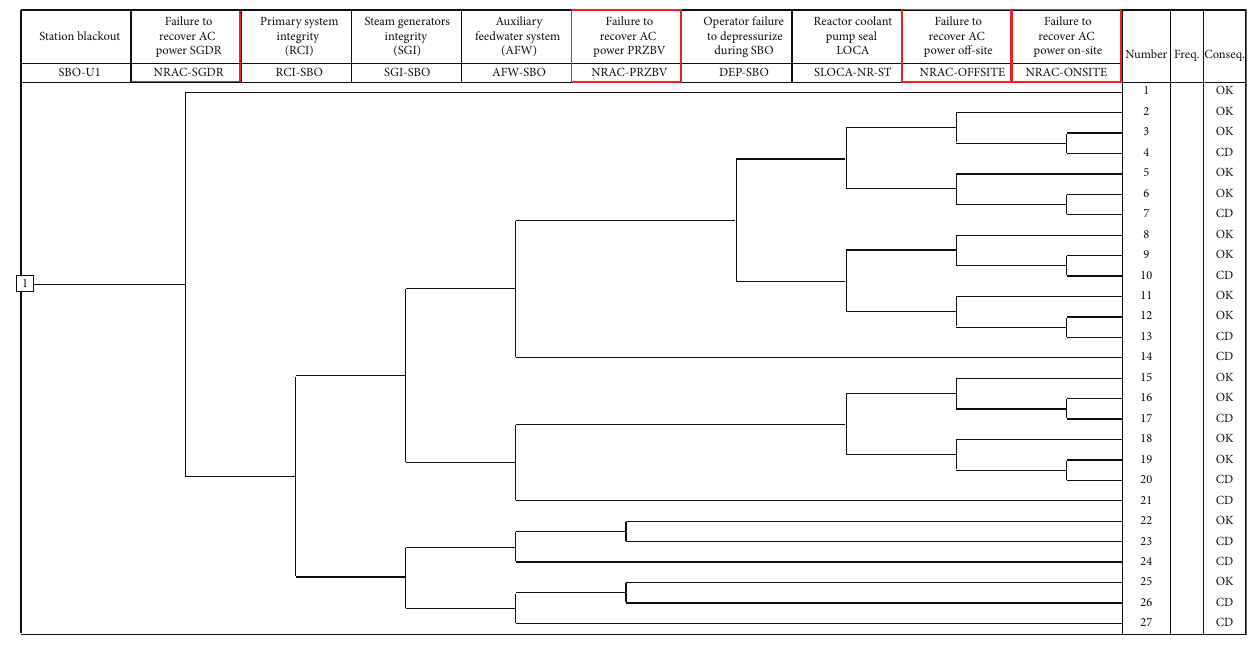
Figure 1: Station blackout event tree.